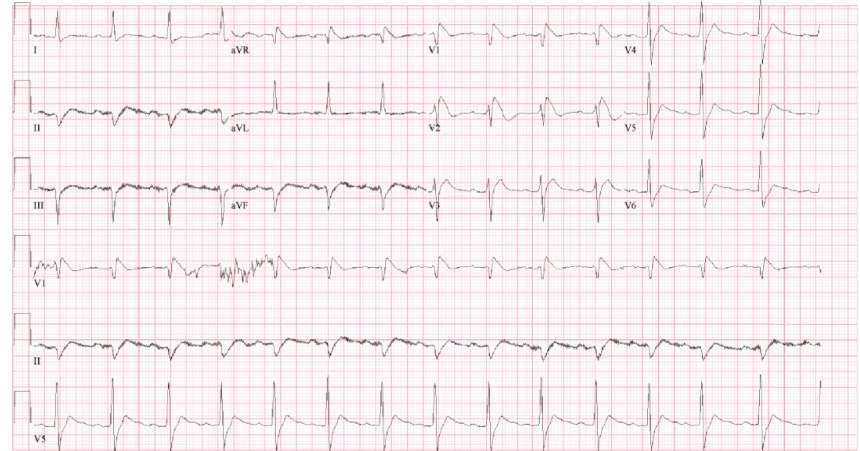
Figure 1: ECG during in-hospital VF arrest: new-onset coved-type ST-segment elevations at anterior precordial